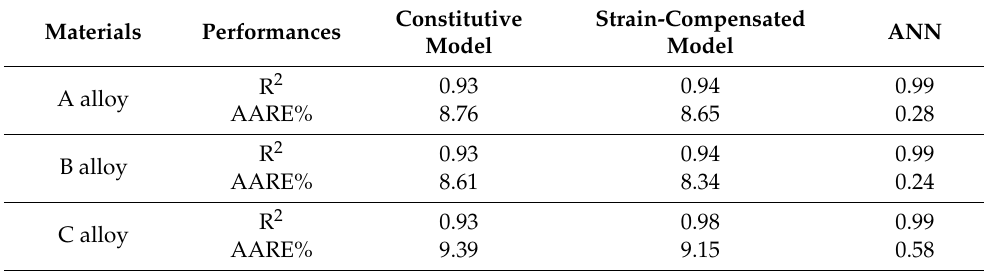
Table 6. Performances of three